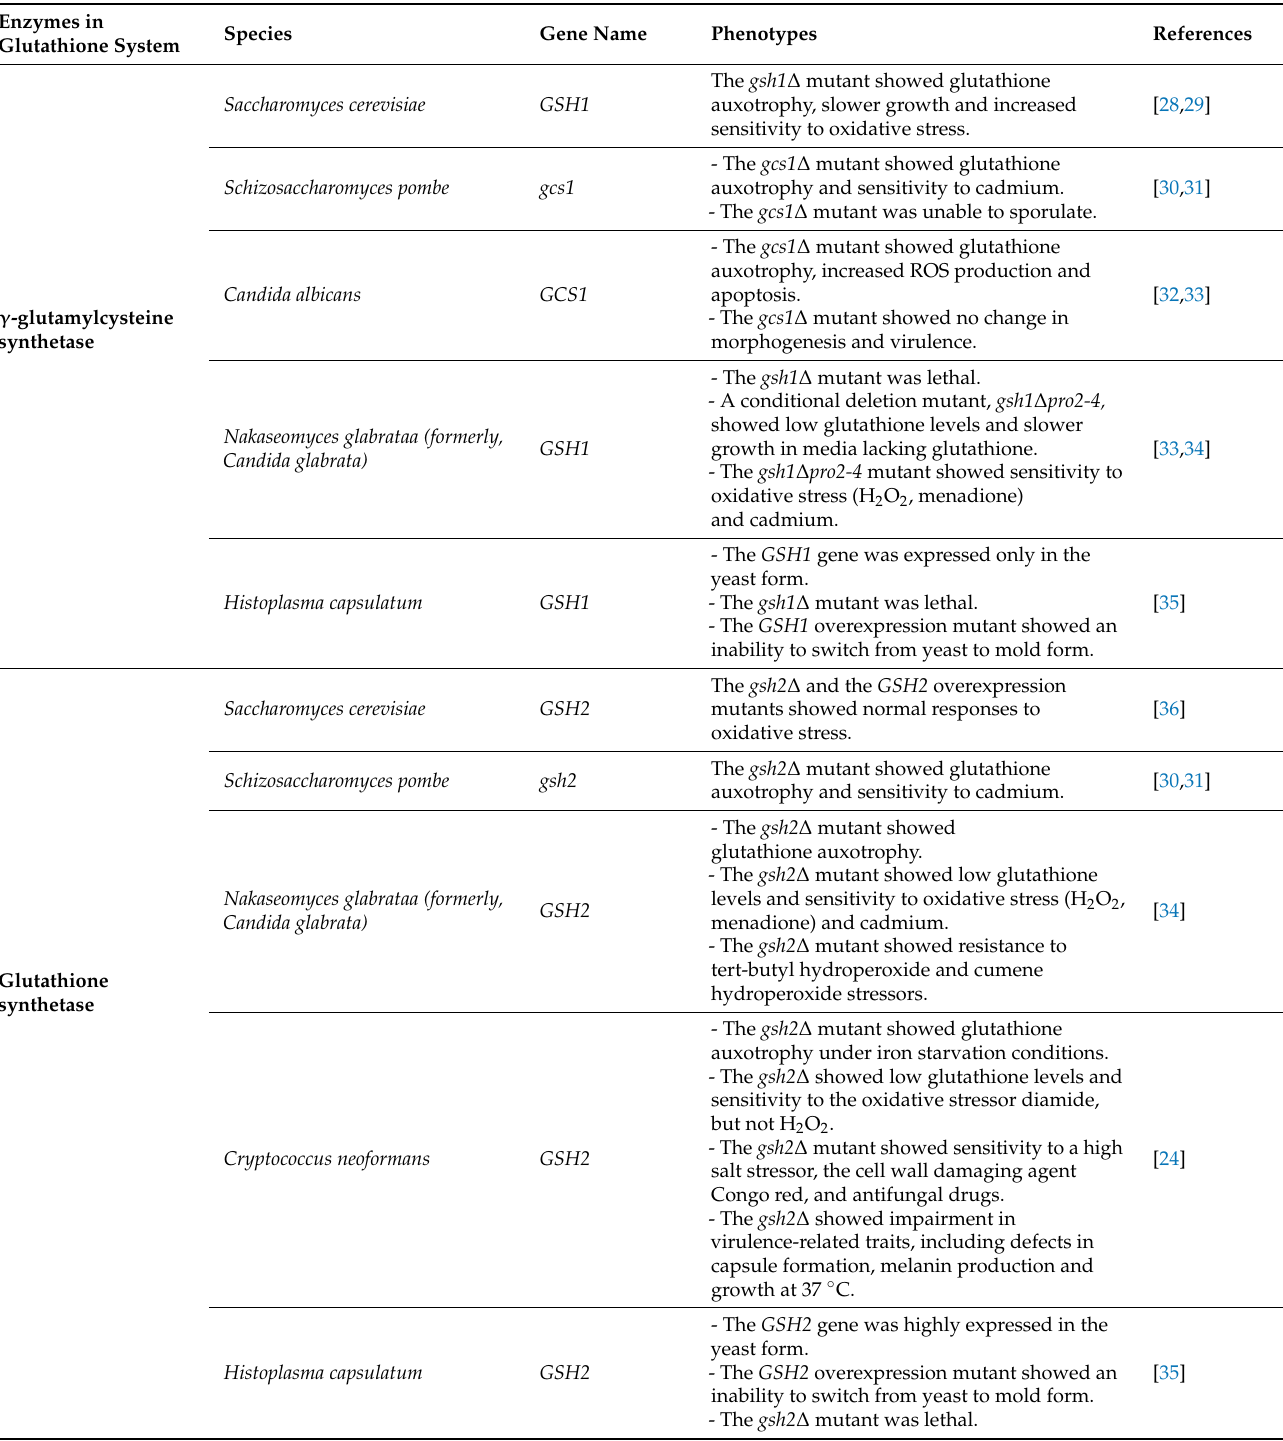
Table 1. Analyses of glutathione-related enzymes in diverse fungal